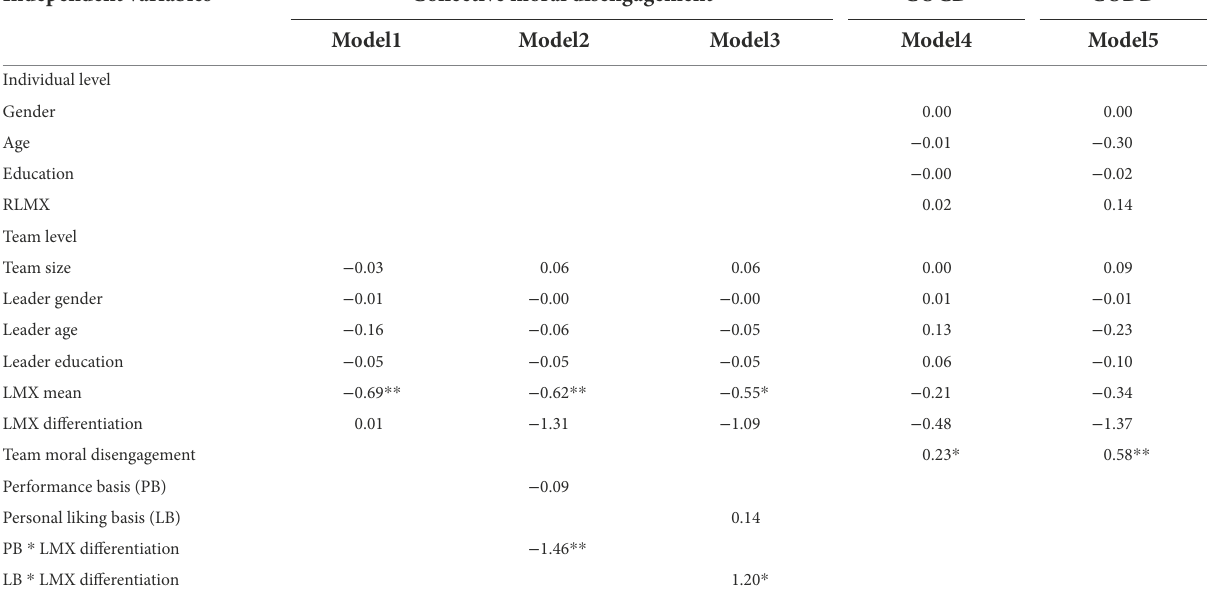
TABLE 2 Results of multilevel path model. Independent